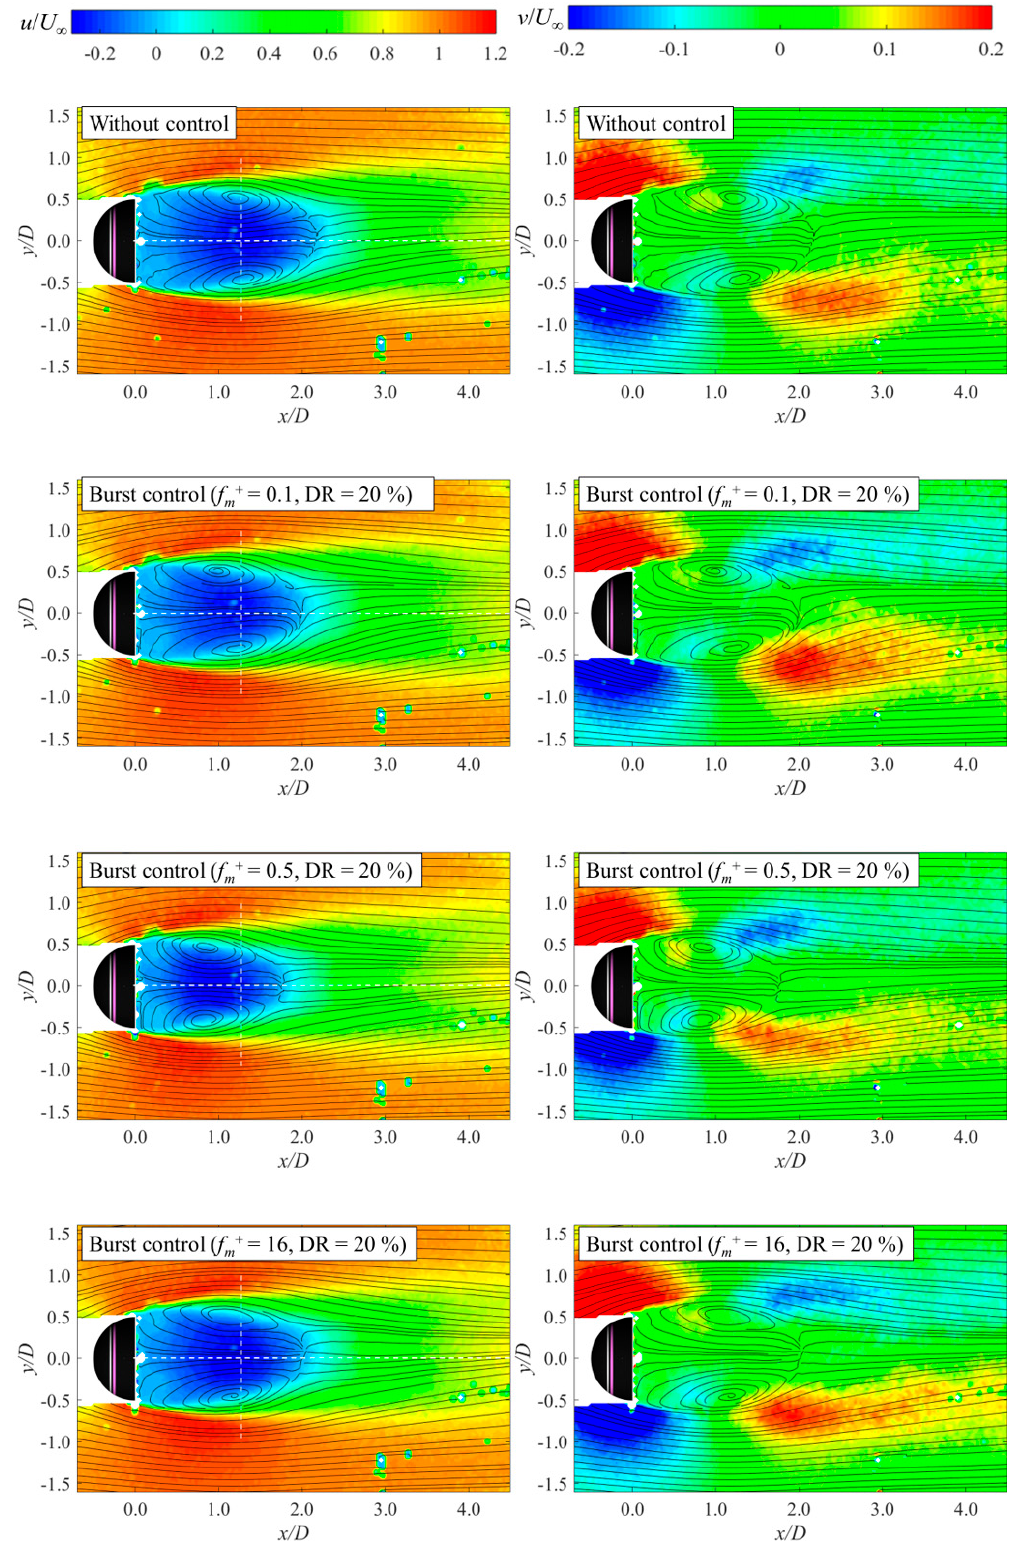
Figure 9. Time-averaged velocity distributions in the x – y cross section ( z / D = − 0.5): u -component ( left ) and v -component ( right ).